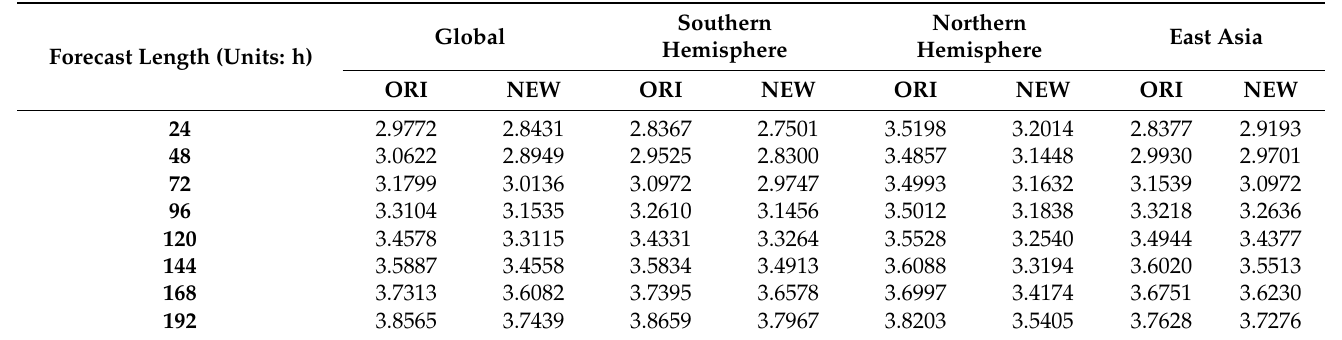
Table 11. RMSE of surface soil temperature between GRAPES forecast and GLDAS over different regions (units: K).